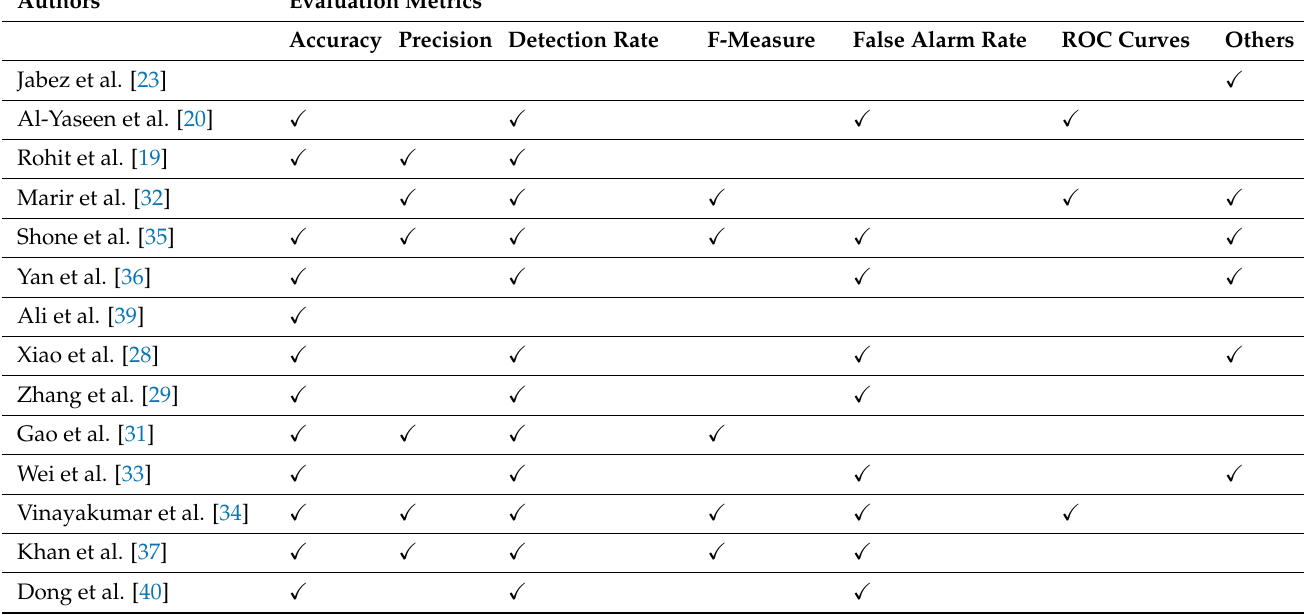
Table 7. Evaluation